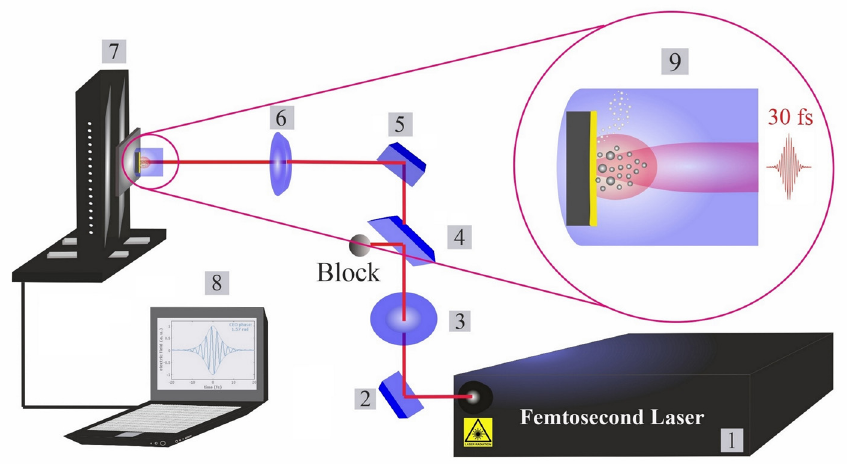
Figure 1. Femtosecond laser ablation and synthesis setup. (1): Femtosecond laser; (2): mirror; (3): half waveplate and polarizer; (4): beam splitter; (5): reflecting mirrors; (6): focusing mirror; (7): motorized XYZ scanning stage; (8): bCNC controller program; and (9): illustration of phases in laser ablation synthesis of nanoparticles in liquids (cavitation bubble growth and the formation of up-flow vapour bubbles).